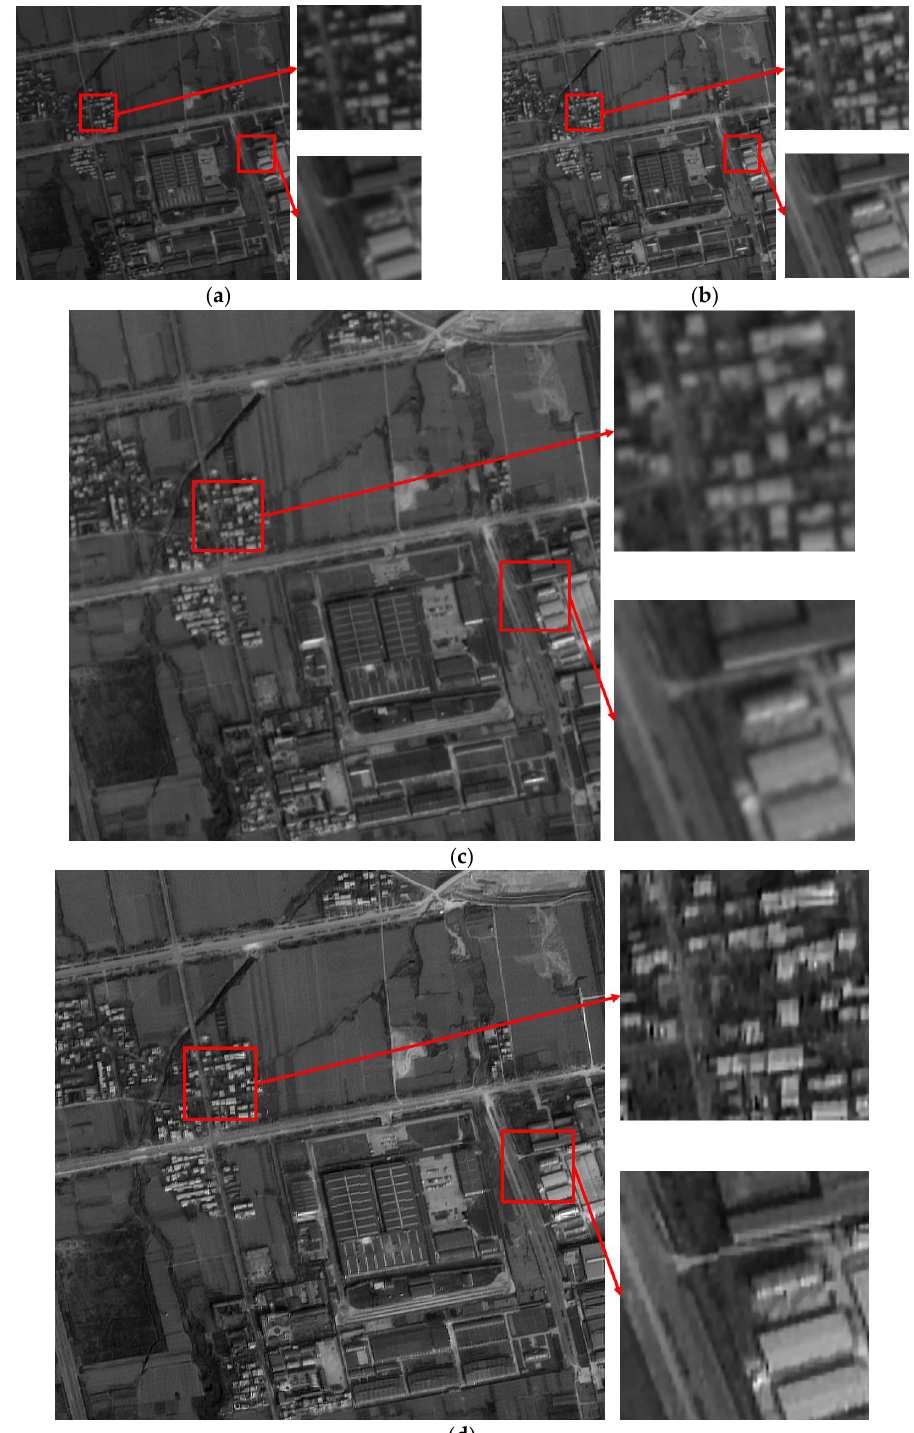
Figure 5. Results of the experiments using two methods: ( a ) original forward image; ( b ) original backward image; ( c ) image based on the bicubic interpolation algorithm; ( d ) image based on the blind SR reconstruction algorithm.